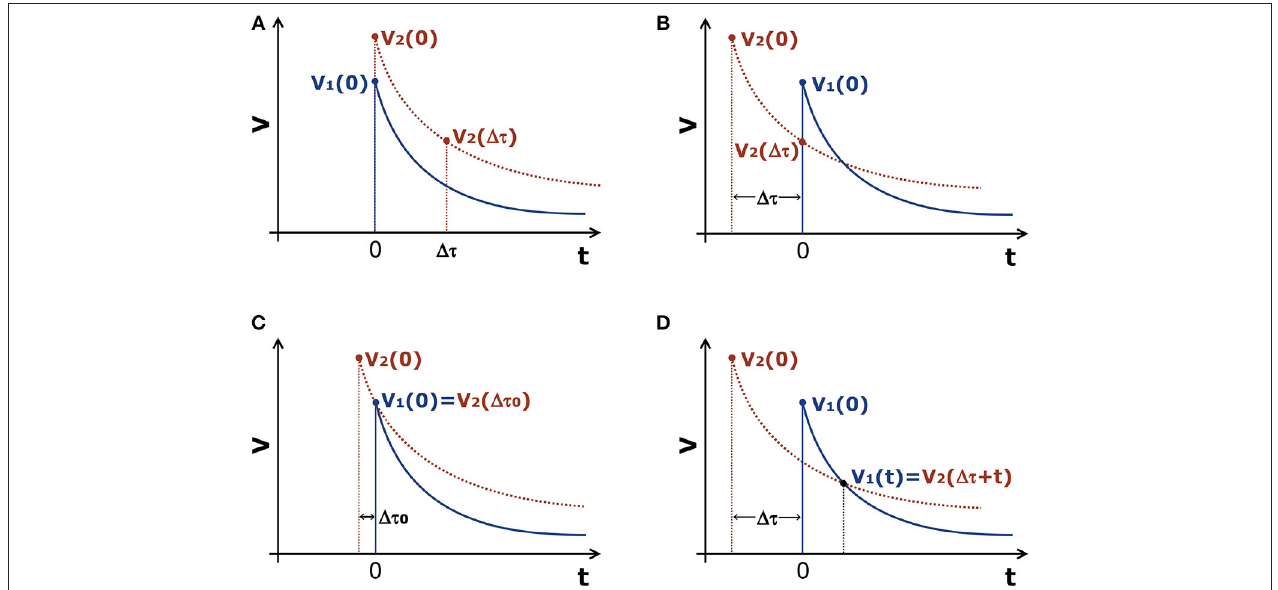
FIGURE 1 | Intertemporal choice process involving two rewards, “1” and “2,” where V 1 (0) < V 2 (0). The curves are from discount models that predict the dynamic inconsistency. The continuous curve refers to V 1 and the dashed one to V 2 . (A) One should choose between these two rewards, to be paid with different delays: V 1 (0) (the objective value of the reward “1”) or V 2 ( 1τ ) (the subjective value of the reward “2” in the delay 1τ ). (B) To facilitate the comparison of these values, the curve of reward “2” was translated to the left to a “distance” of 1τ , so that V 1 (0) and V 2 ( 1τ ) were vertically aligned; one sees that V 1 (0) > V 2 ( 1τ ), which leads to the choice of reward “1.” (C) Decreasing gradually the value of 1τ , shifting the curve of reward “2” to the right, one finds a delay ( 1τ 0 ) where V 1 (0) = V 2 ( 1τ 0 ). In this case, 1τ 0 is analogous to the “proper time” of the special theory of relativity and it is defined as the maximum delay from which individuals prefer the greater and later reward to the smaller and immediate one. (D) There is a specify value of t where V 1 ( t ) = V 2 ( 1τ + t ). Here, There is an intertemporal preference reversal, because from this point individuals prefer the greater and later reward, V 2 ( 1τ + t ), to the smaller and more immediate one, V 1 ( t ).